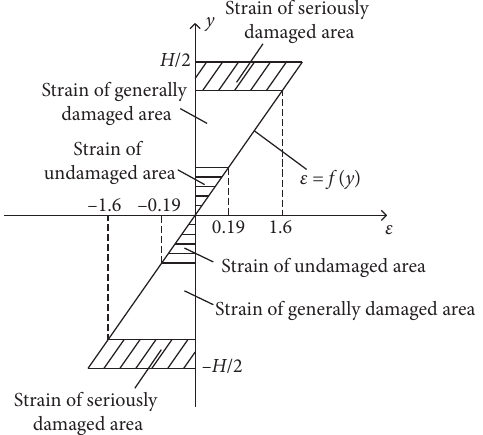
Figure 10: Strain distribution characteristics of seriously damaged cross section.